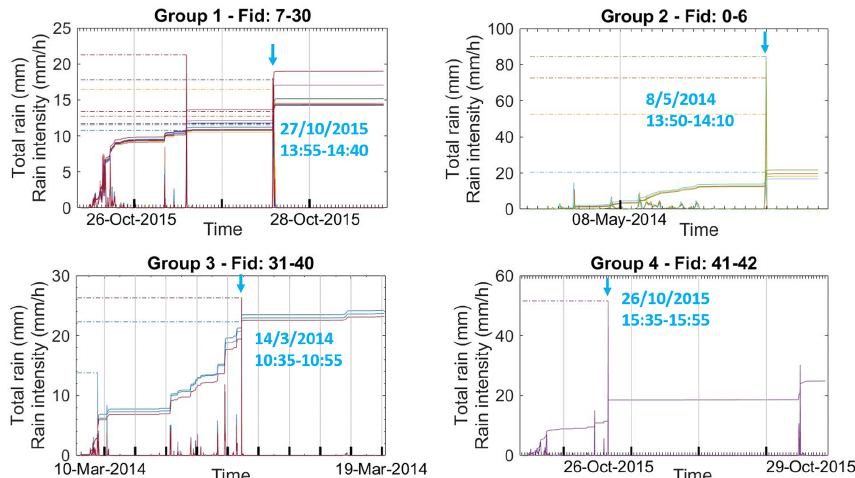
Figure 7. Rainfall evolution over the DF locations during the triggering storms (see Table 1). For each group we plot the intensity (spikes) and cumulative rain (stairs graph) during the triggering storm for all DF locations (where “Fid” is the identification number of the DF) in the group (the different line colors). Dashed lines mark the peaks of rain intensity. A blue arrow marks the triggering cell during each storm. Note that the y axis shows both rain intensity (in mmh − 1 ) and total cumulative rain during the storm (in